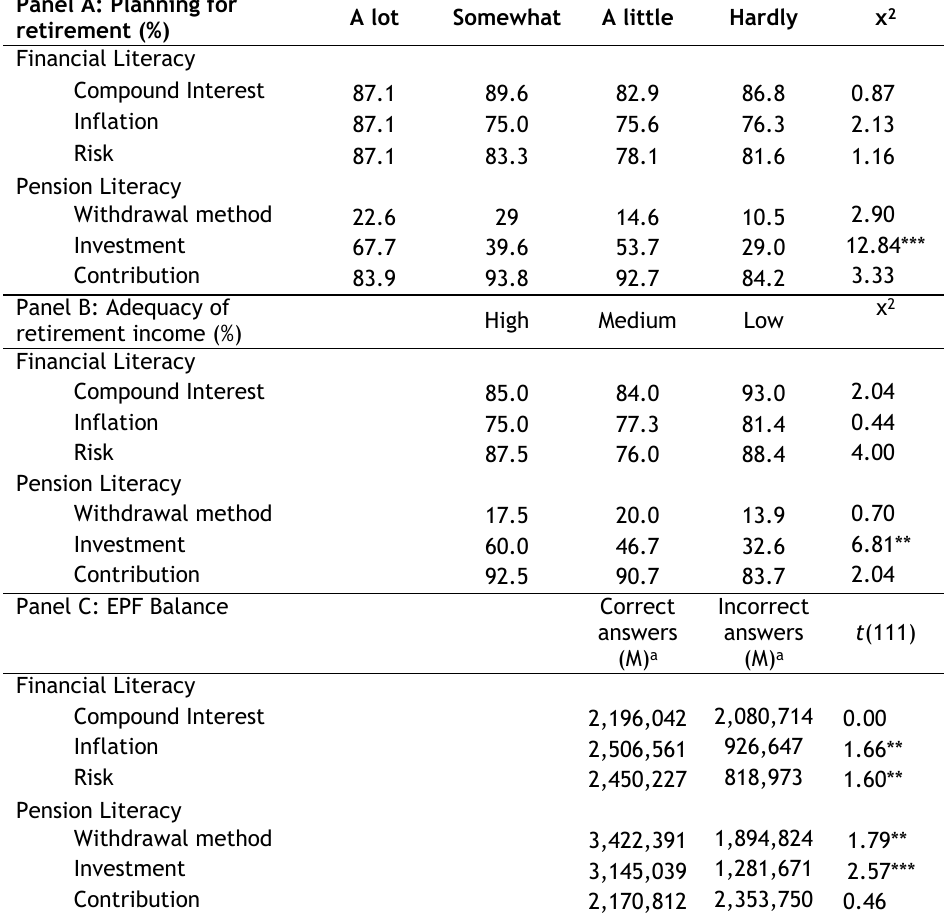
Table 2. Retirement preparedness level by financial and pension